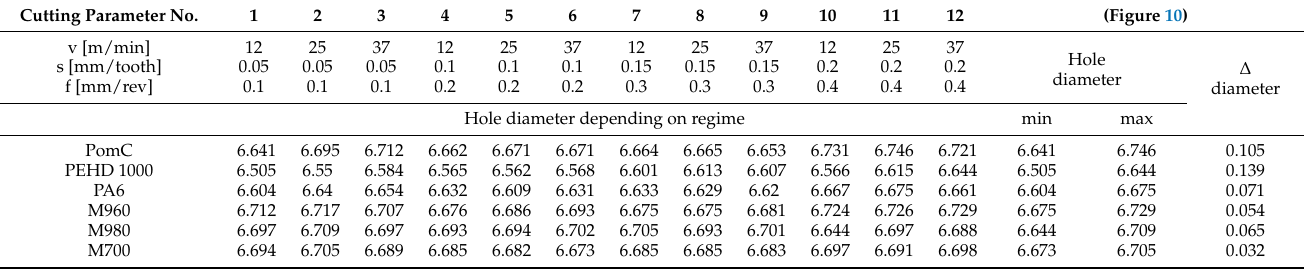
Table 7. The measured diameters of the holes depending on the material and cutting